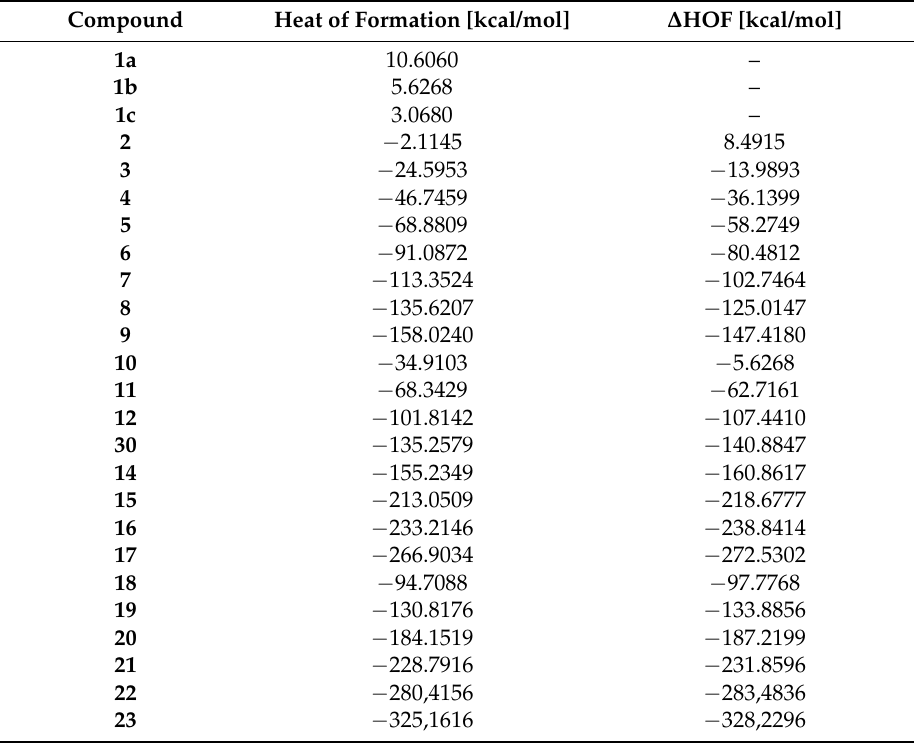
Table 1. Heat of formation (HOF) [kcal/mol] of di-, tri- and tetrabromosubstituted derivatives